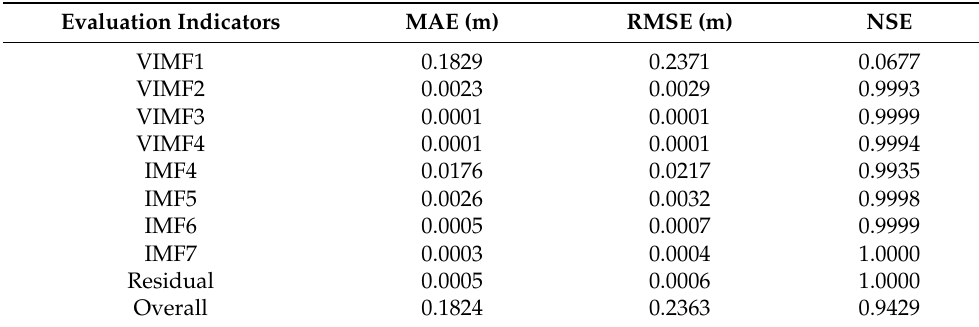
Figure 9. Predicted groundwater depth in the People’s Victory Canal irrigation area. Table 2. Predicted effects of groundwater depth of burial for each component and